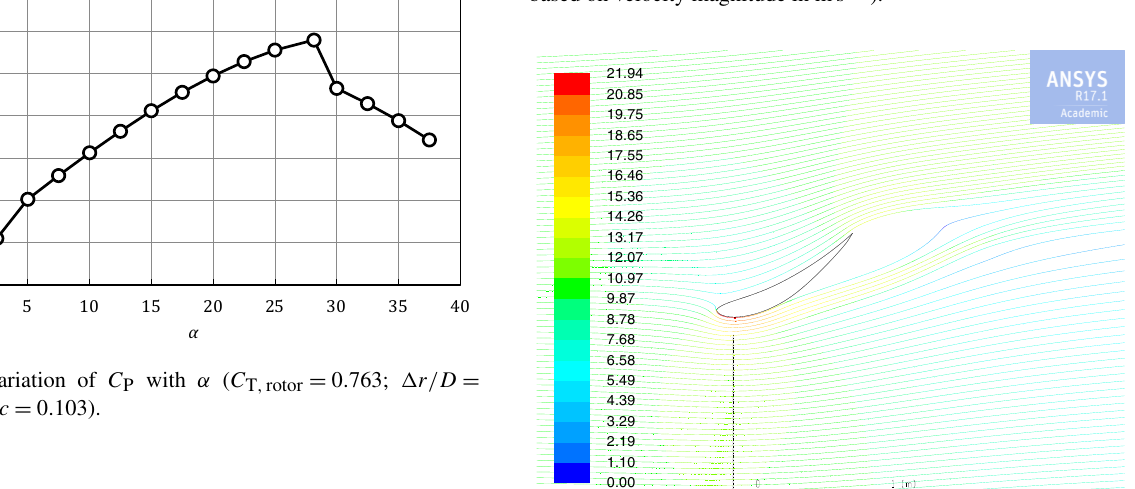
Figure 7. Streamlines at α = 28 . 2 ◦ (the streamlines are colored based on velocity magnitude in ms − 1 ).